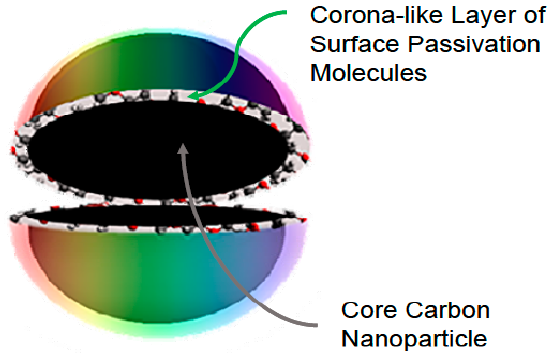
Figure 1. A cartoon illustration on the structure in carbon dots (CDots).